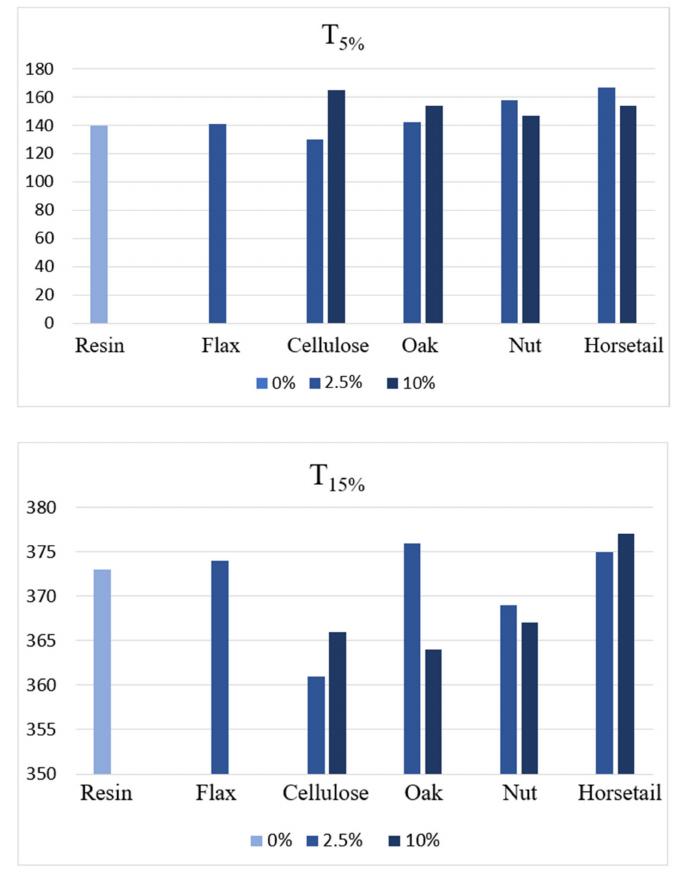
Figure 20. Temperatures in which 5% and 15% weight loss of the sample were